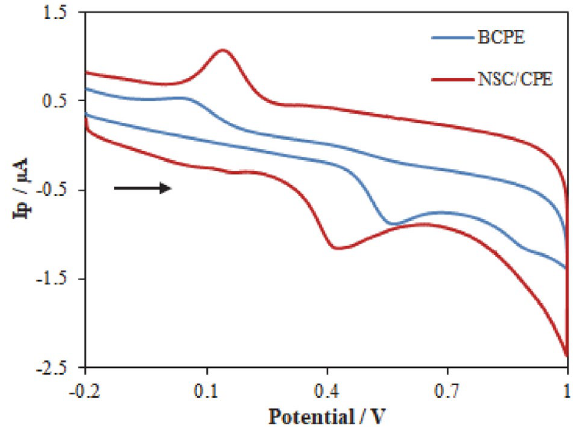
Fig. 3. Cylic voltammograms of 1.0 × 10 –4 molL –1 HQ at BCPE (blue line) and NSC/CPE (red line) in 0.04 M BR buffer, pH 2.0, scan rate: 0.1 Vs –1 . Table 1. Comparison of peak potential and peak current of 1.0 × 10 –4 molL –1 HQ on BCPE and NSC/CPE by using CV method, pH: 2.0 BR buffer, scan rate: 0.10 Vs –1 .